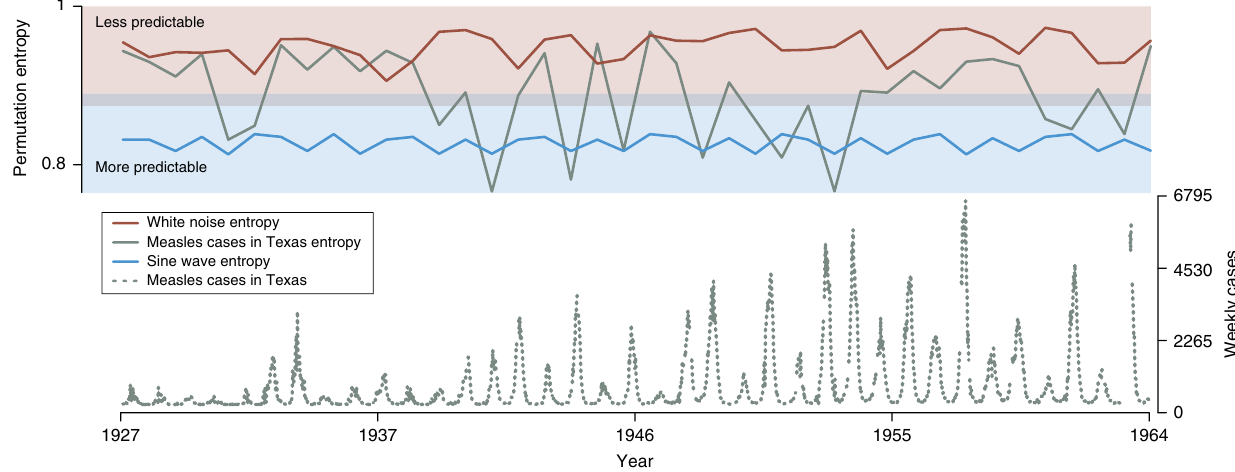
Fig. 1 Permutation entropy varies through time for real-world disease time series. The permutation entropy in windows of size 52 weeks across three time series of equal length: (1) dark red: Gaussian – white – noise ( μ = 0, σ = 1); (2) gray: measles cases reported to the United States Centers for Disease Control and Prevention from the state of Texas between 1927 and 1965 (gray dashed line, lower panel) as digitized from MMWR reports by Project Tycho 60 ; and (3) blue: a sine wave with Gaussian noise ( μ = 0, σ = 0.01). The fl uctuations in the permutation entropy calculated from the measles time series (gray dashed line) are larger than would be predicted by chance and result in periods of time where model-based forecasts should be accurate (in the range of a noisy sine wave, blue shaded region) and periods of time (in the range of the white noise, red shaded region) when statistical forecasts based solely on the time-series data should outperform model-based